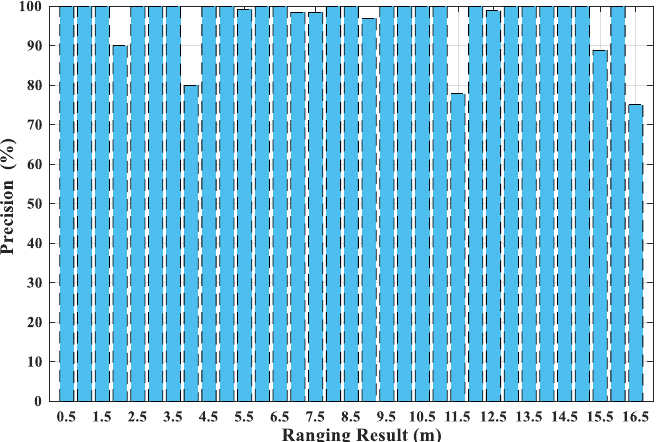
Figure 10. Precision at different ranging results.